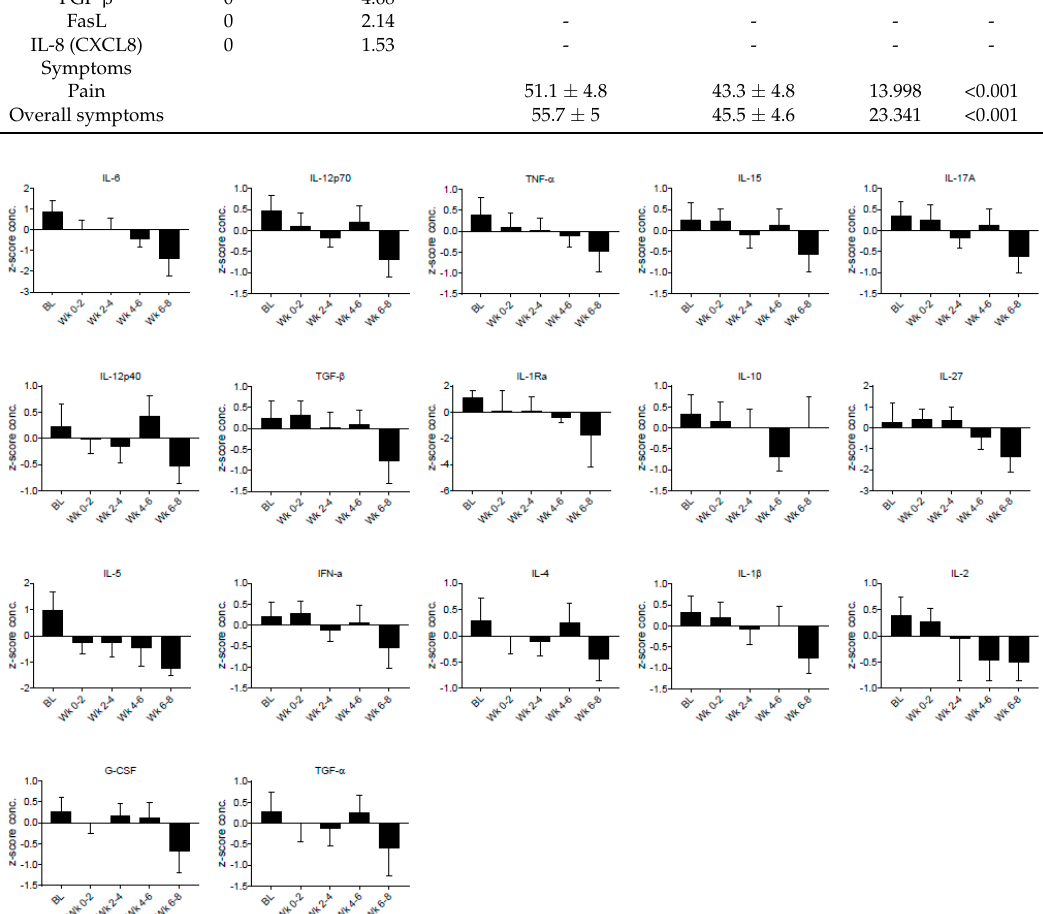
Figure 1. The average plasma concentrations of each cytokine found to be significantly reduced between baseline (BL) and Drug. On the y -axis, data are presented as the mean and 95% confidence intervals of within-person z -score standardized concentrations, as this provides the most accurate representation of change across the study. The x -axis shows the time in blocks of two weeks, starting with baseline (BL).